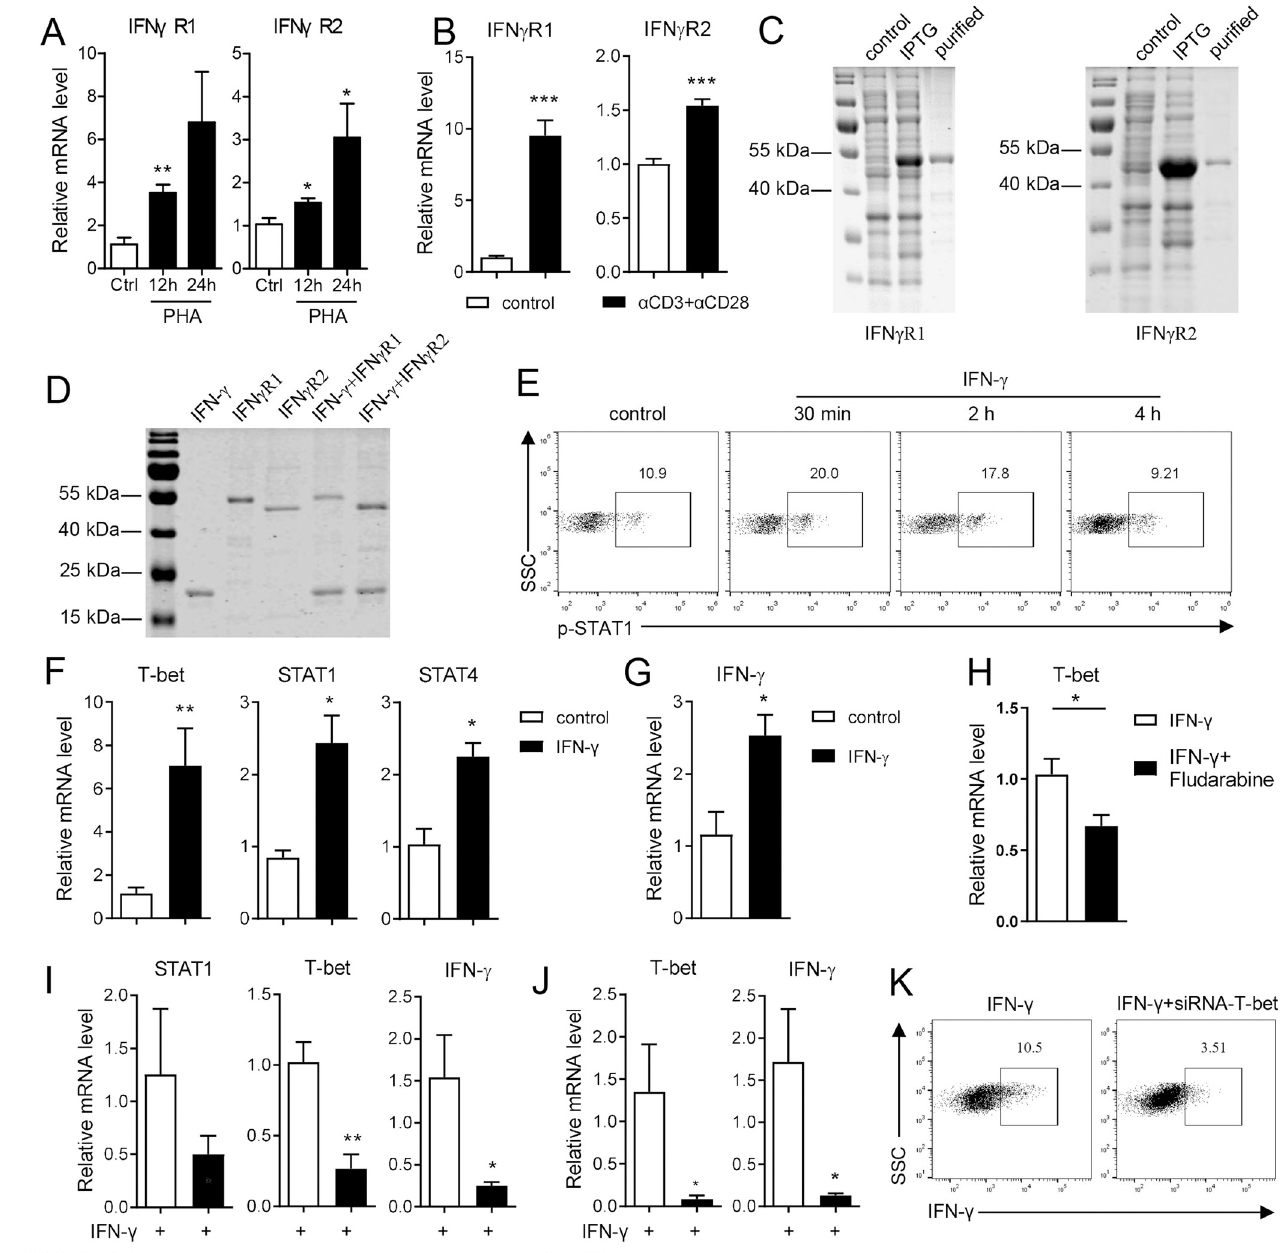
Fig 8. IFN- γ enhances tilapia Th1 cell commitment. ( A, B ) Spleen leukocytes were stimulated with PHA or CD3 ε /CD28 mAbs for 12 h, and mRNA levels of IFN γ R1 and IFN γ R2 were examined by qPCR, n = 6. ( C ) SDS-PAGE assay showed the recombination of tilapia IFN γ R1 and IFN γ R2 with GST-tag in E . coli . ( D ) GST pull-down assay showed the interaction of tilapia IFN- γ with IFN γ R1 and IFN γ R2. ( E ) Flow cytometry showed the phosphorylation level of STAT1 in lymphocytes that stimulated with recombinant IFN- γ . ( F, G ) Spleen leukocytes were stimulated with recombinant IFN- γ for 12 h, and mRNA levels of indicated molecules were examined by qPCR, n = 5. ( H ) Tilapia was injected with STAT1 inhibitor for 2 days before spleen leukocytes were stimulated with recombinant IFN- γ for 12 h. The expression levels of T-bet were examined by qPCR, n = 6. ( I-K ) Spleen leukocytes from tilapia that i . p . injected with T-bet- specific, STAT1-specific or control siRNA for 2 days were harvested and stimulated with recombinant IFN- γ for 12 h. Relative mRNA levels of STAT1, T-bet and IFN- γ ( I, J , n = 5), and the percentage of IFN- γ + cells in gated CD3 + CD4-1 + T cells ( K ) were examined. These experiments were repeated for at least two independent times. � : p < 0.05, �� : p < 0.01, ��� : p < 0.001, determined by a two-tailed Student’s t-test.